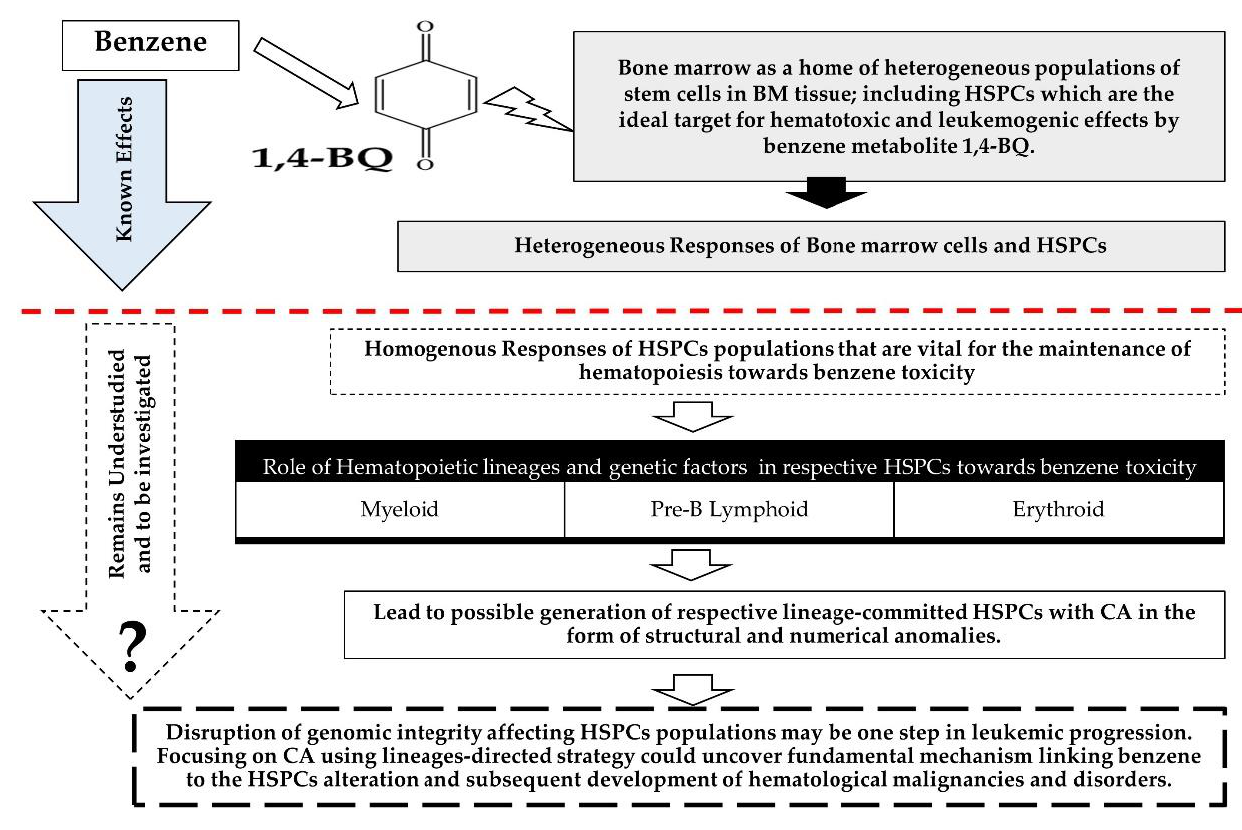
Figure 1. The elucidation of the genotoxicity of benzene in the respective population of lineage-committed HSPCs comprising myeloid, lymphoid and erythroid lineages focusing on CA in the form of structural and numerical anomalies. Heterogeneous responses of bone marrow cells including HSPCs towards benzene toxicity have been reported. However, homogenous responses of HSPC populations towards benzene toxicity remains unexplored and to be investigated. The study focusing on CA using lineage-directed strategy is fundamental to uncover a novel mechanism linking benzene to the disruption of genomic integrity affecting HSPCs populations and subsequent development of hematological malignancies and disorders.